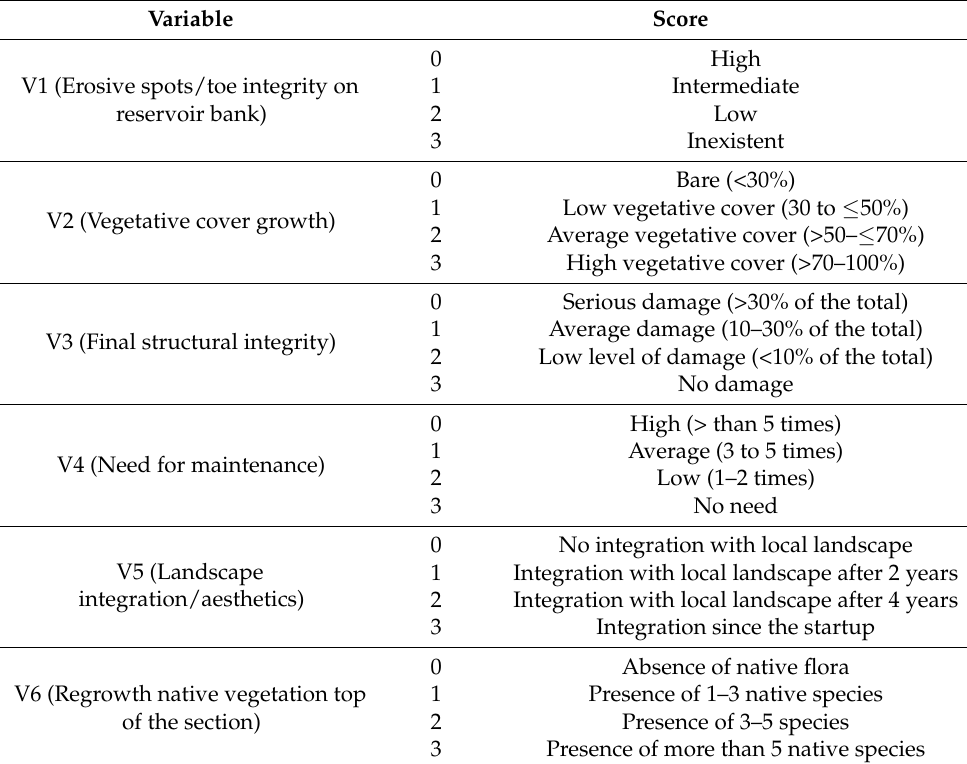
Table 4. Performance matrix of the evaluation.